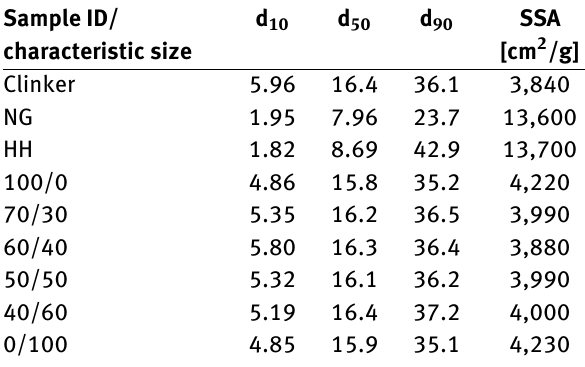
Table 2: Particle sizes distribution of the clinker and cement with different mass proportions of NG and HH for a 4% total mass of calcium sulfate within the